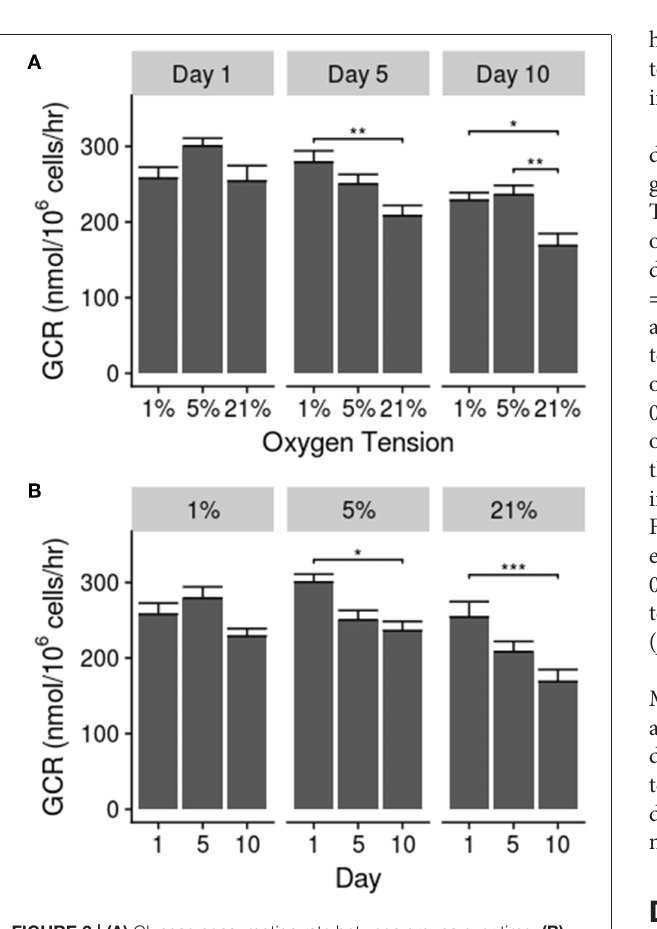
FIGURE 2 | (A) Glucose consumption rate between groups over time. (B) Glucose consumption rate over time in each oxygen tension. Data presented as mean ± standard error of the mean; statistical significance shown as * p ≤ 0.05, ** p ≤ 0.01, and *** p ≤